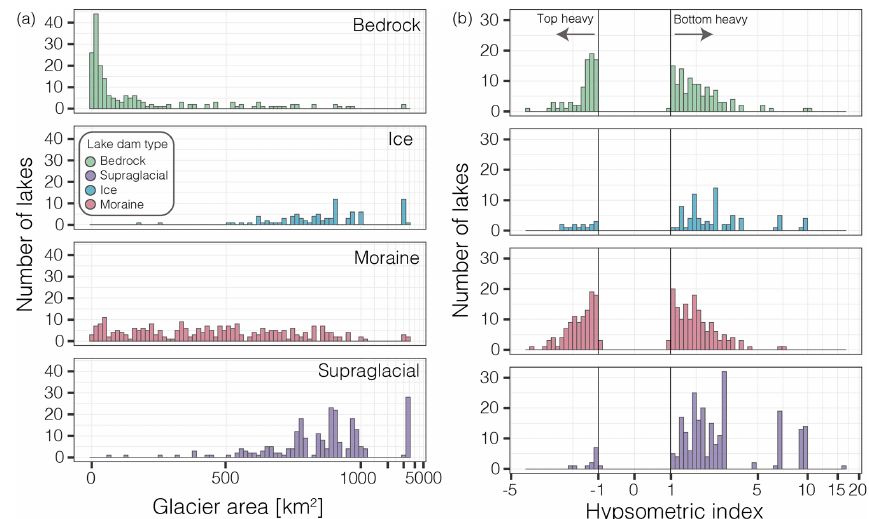
Figure 10. Histogram of number of lakes and associated glacier area, separated by dam type (a) , and histogram showing number of lakes within each hypsometric index (HI) bin, separated by dam type (b) . Hypsometric index was calculated by McGrath et al. (2017). HI values greater than 1 indicate a bottom-heavy glacier, and HI values less than − 1 indicate a top-heavy glacier. Note the logarithmic x -axis scales.